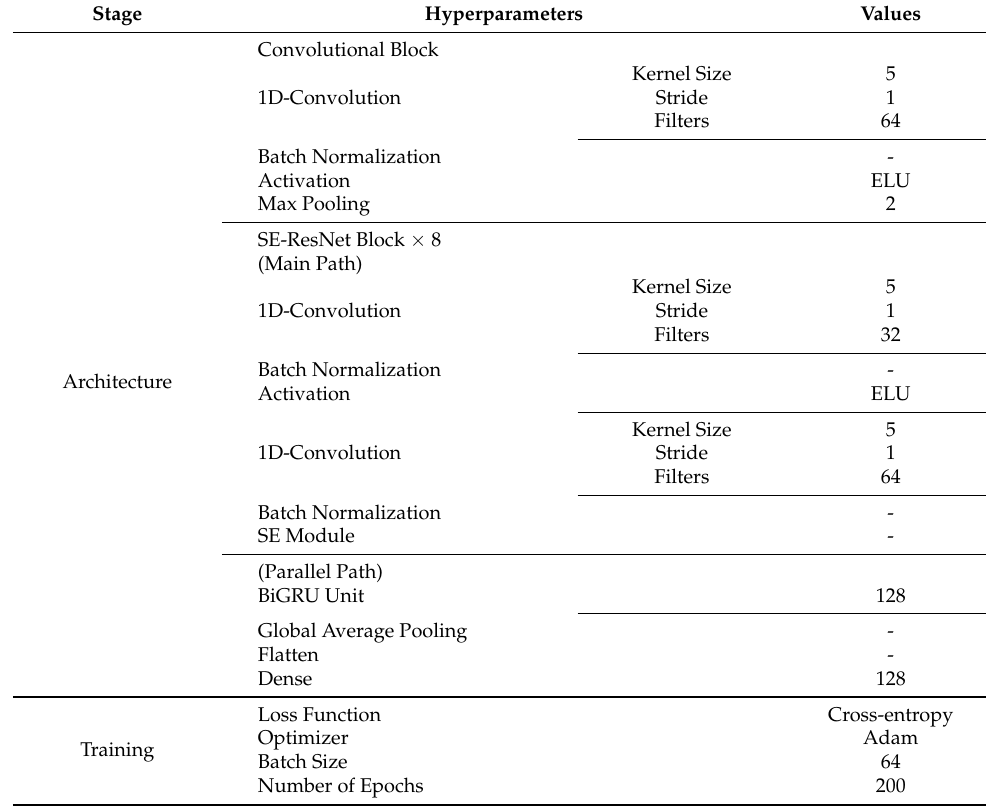
Table A4. The summary of hyperparameters for the SEResNet-BiGRU network used in this